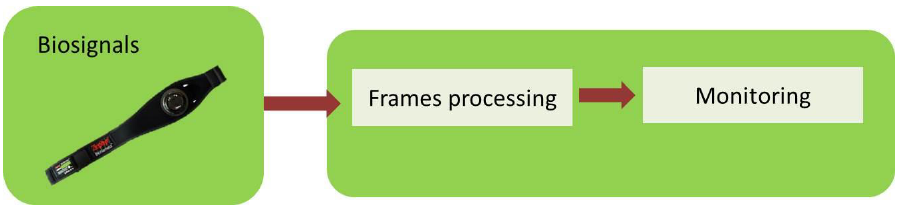
Figure 8. Block A—Monitoring.